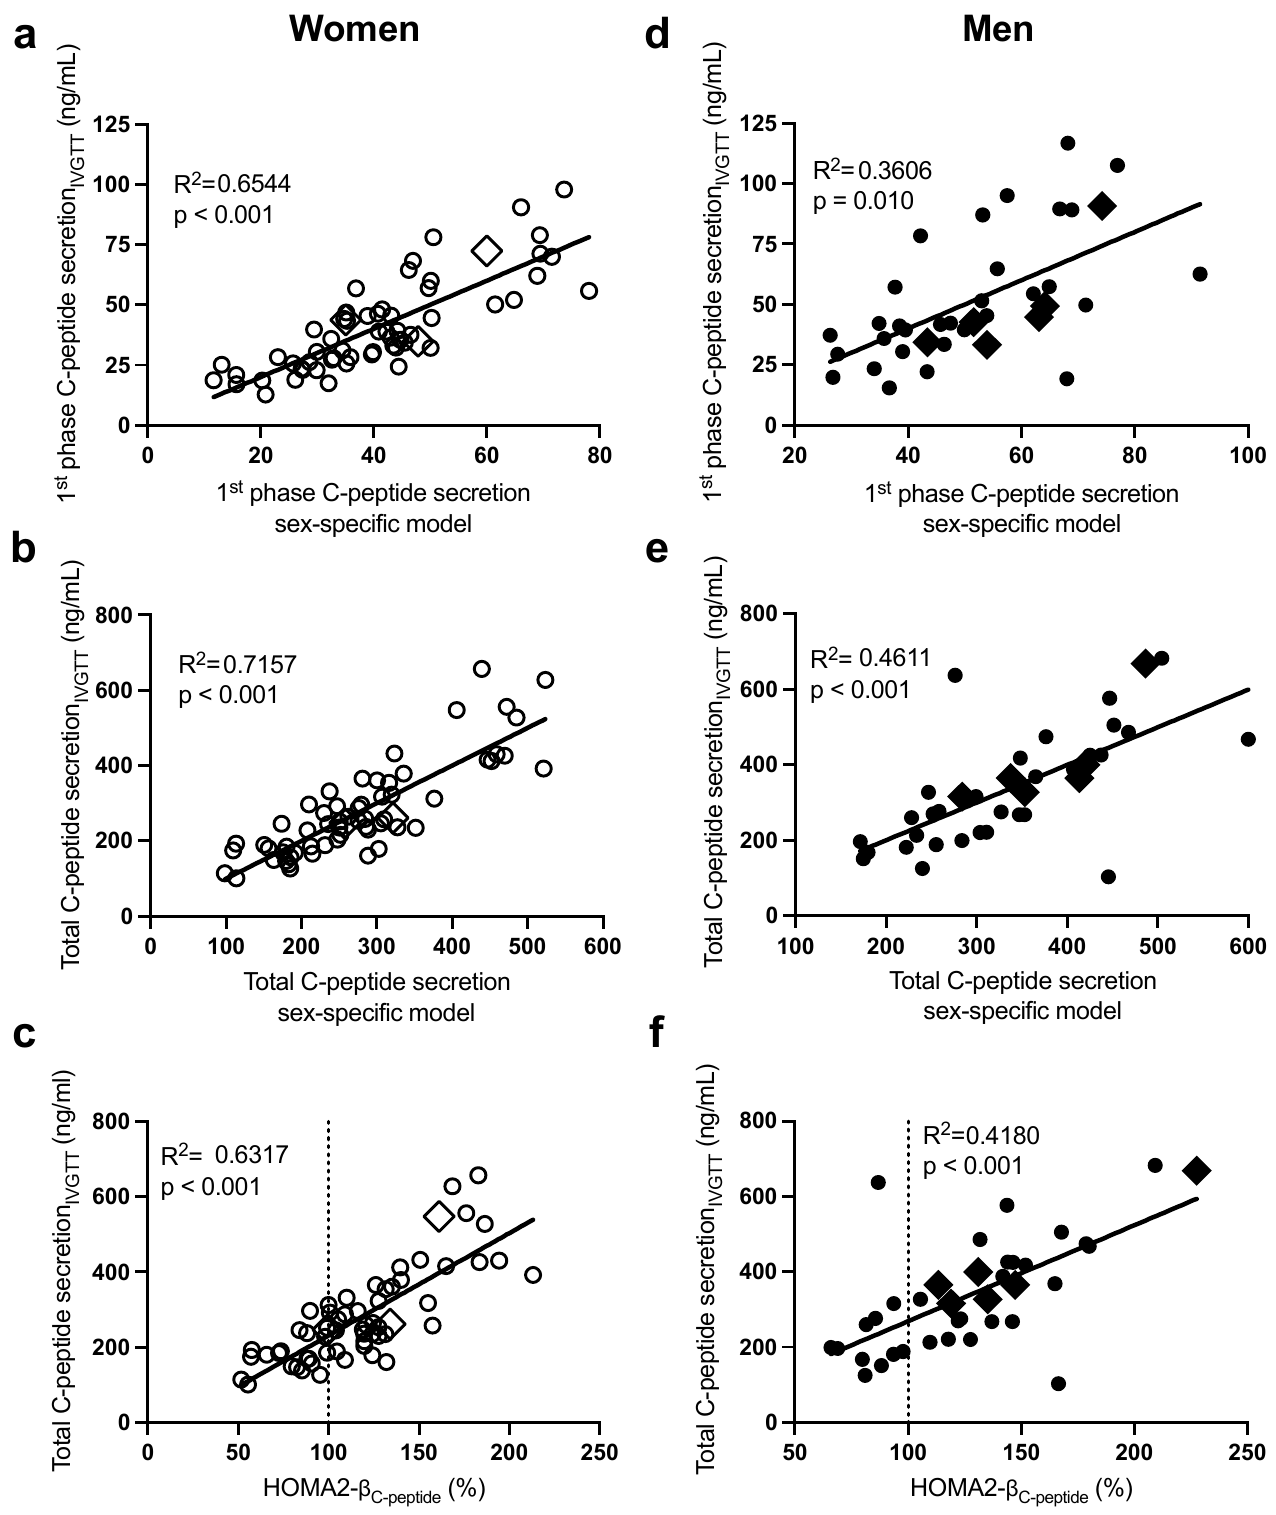
Figure 2. Pearson correlations between the sex-specific models, with their corresponding data for first-phase C-peptide secretion IVGTT in women ( a ) and men ( d ) and total C-peptide secretion IVGTT in women ( b ) and men ( e ), and between HOMA2- β C-peptide with total C-peptide secretion IVGTT in women ( c ) and men ( f ). Women are in open circles (N = 61, those with BMI > 40 kg/m 2 are in open diamonds) and men are in closed circles (N = 37, those with BMI > 40 kg/m 2 are in closed